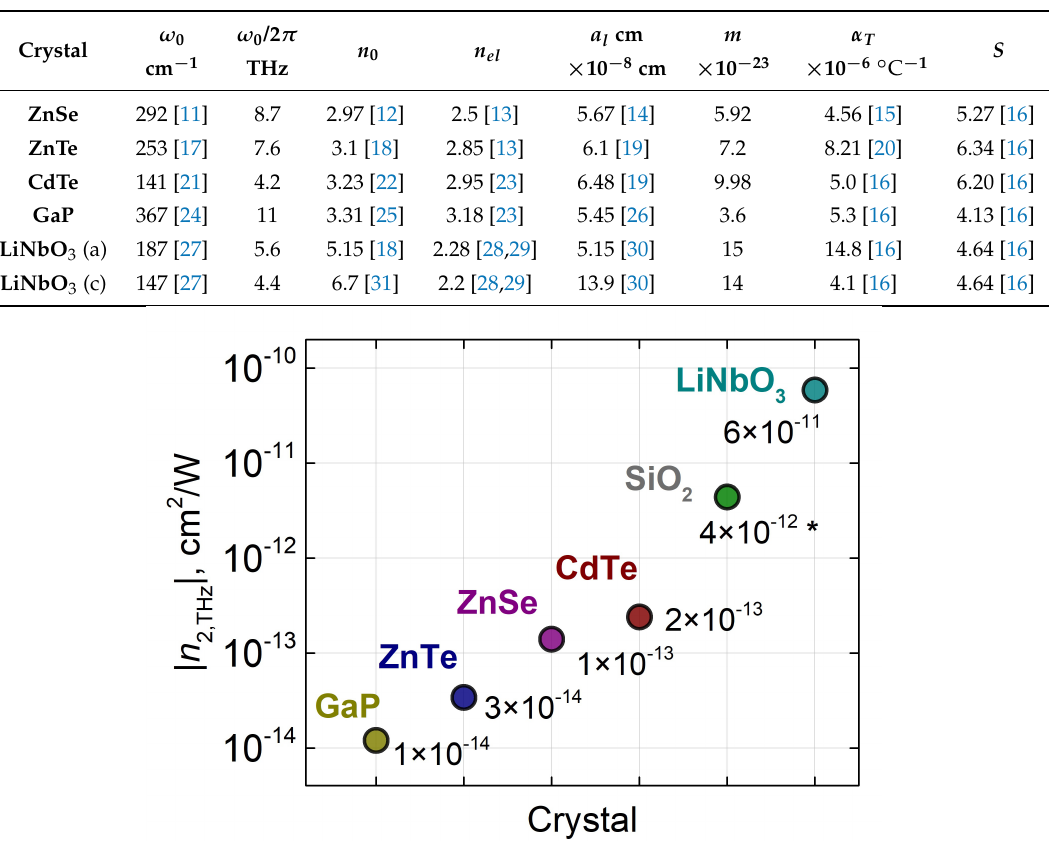
Table 1. Parameters for n 2, THz calculations.